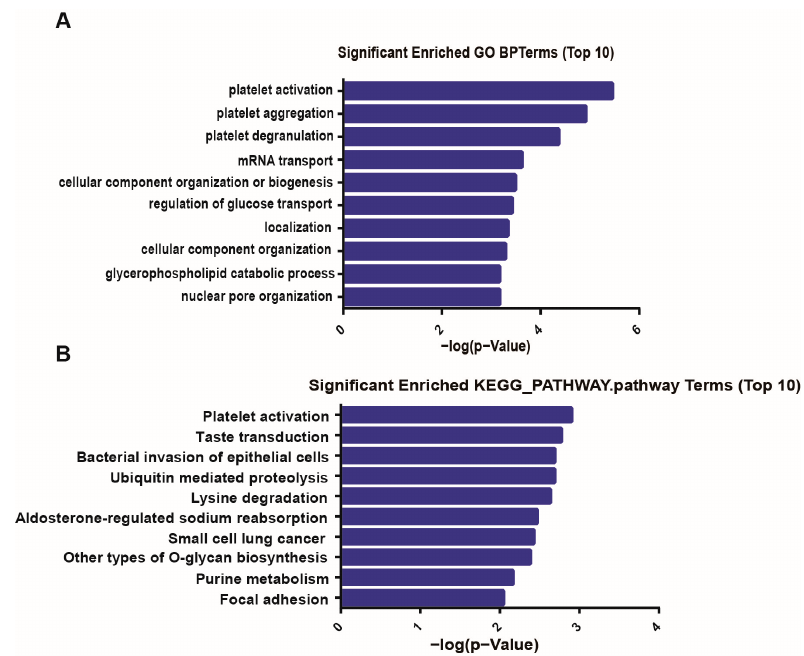
Pearson’s correlation is 0.649. The cohort included 30 patients with HF and 30 control individuals.